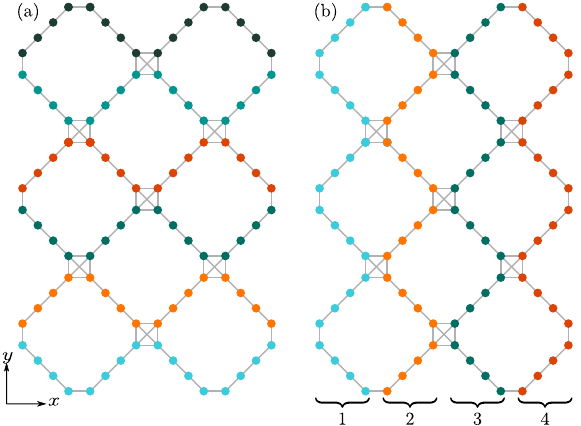
Fig. 7 Labeling of the proposed architecture. The generalized a rows and b columns m = 4, d x = 2 and d y = 3 are shown. Qubits of the same color are in the same row or column. Lines indicate between which qubits a two-qubit gate can be applied.